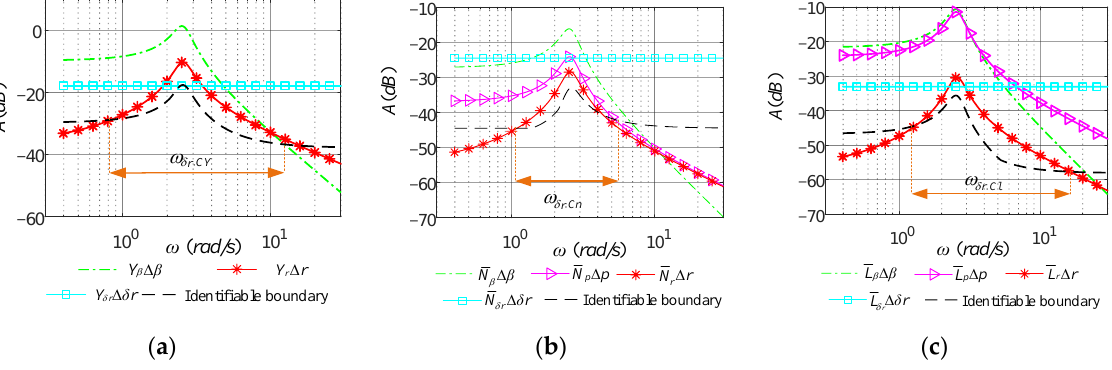
Figure 15. Amplitude–frequency characteristics of lateral-directional aerodynamic parameters varying with rudder frequency. ( a ) Side force; ( b ) Yawing moment; ( c ) Rolling moment.